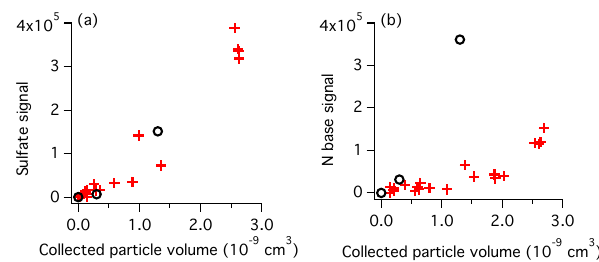
Figure 2. Solid line: estimated TDCIMS particle sampling ef- ficiency as a function of mobility diameter for bulk (non-size- resolved) sampling. Dashed line: the same number efficiency scaled by the volume of an individual particle at each size and normalized to fit on the same plot (arbitrary units). These estimates include the effects of sampling losses, (multiple) charging efficiency, and effi- ciency of capture by the electrostatic precipitator. Small ( < 15nm) particles are efficiently captured due to their high mobility. The effi- ciency of collection at sizes below 4nm could not be assessed using the available experimental apparatus, but particles at smaller sizes are not likely to have contributed detectable amounts of particle mass during these experiments.